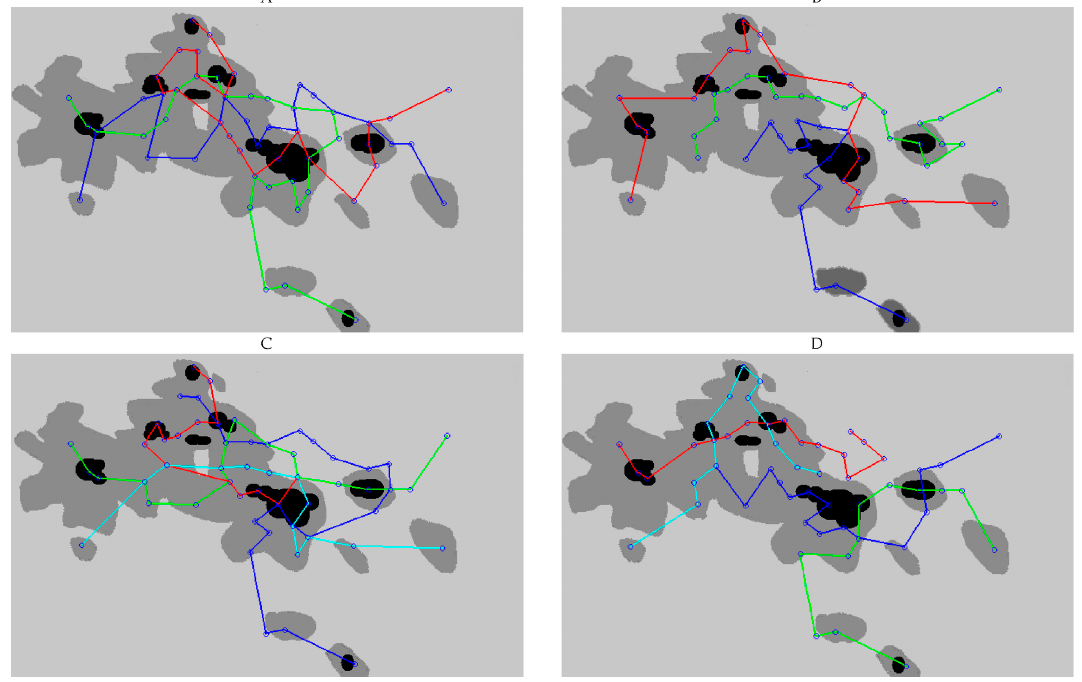
Figure 9. The best solutions of lines topology for all examined cases (according to Table 6).